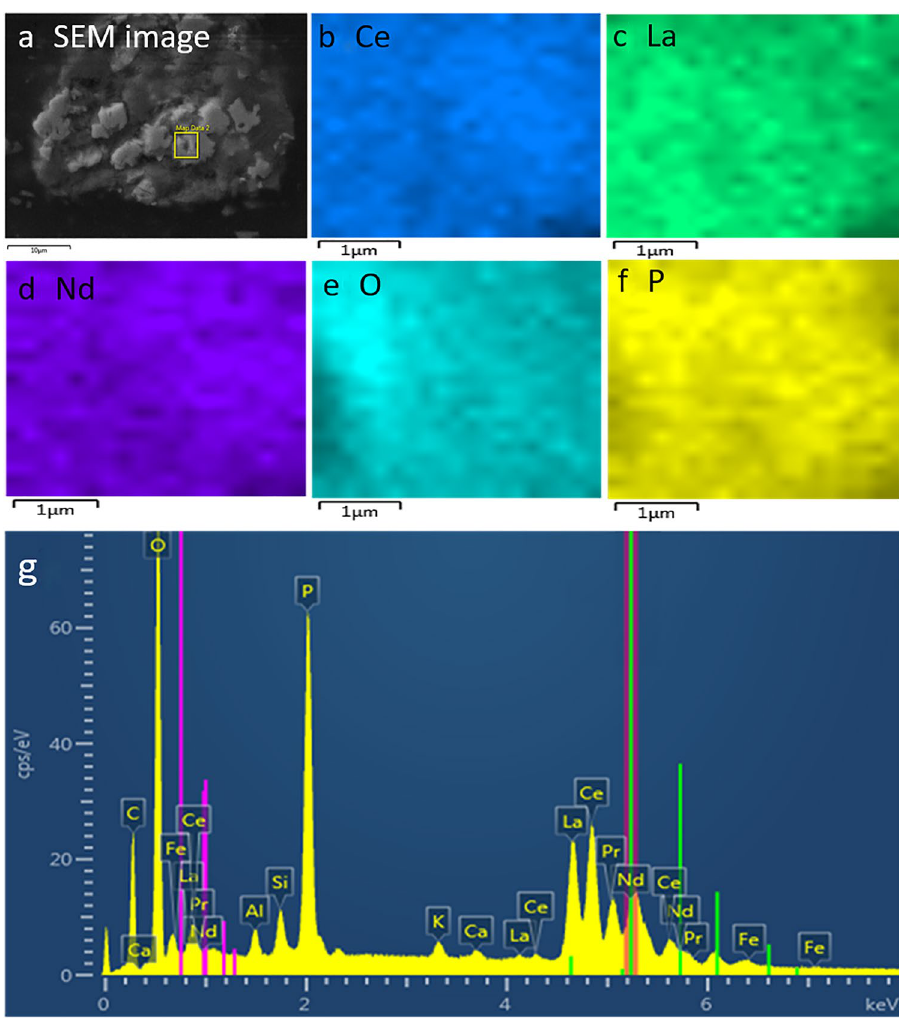
Fig. 4 a SEM image of a 50 μ m × 50 μ m region of sample PE-02. b Element mapping images for b Ce, c La, d Nd, e O and f P of the PE-02 sample in a 3 μ m × 3 μ m region indicated by the yellow square in ( a ). g EDS spectra obteined from the 3 μ m × 3 μ m region showed